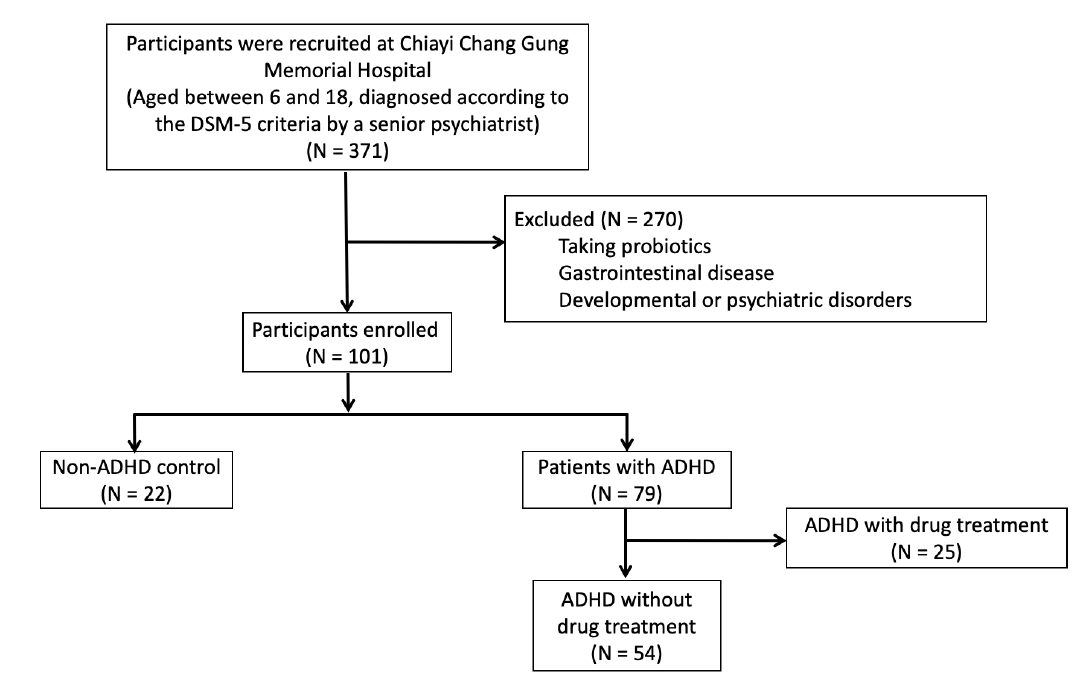
Figure 1. Flowchart of enrollment of the study participants. Table 1. Baseline characteristics of ADHD children with treatment-naïve and health controls.